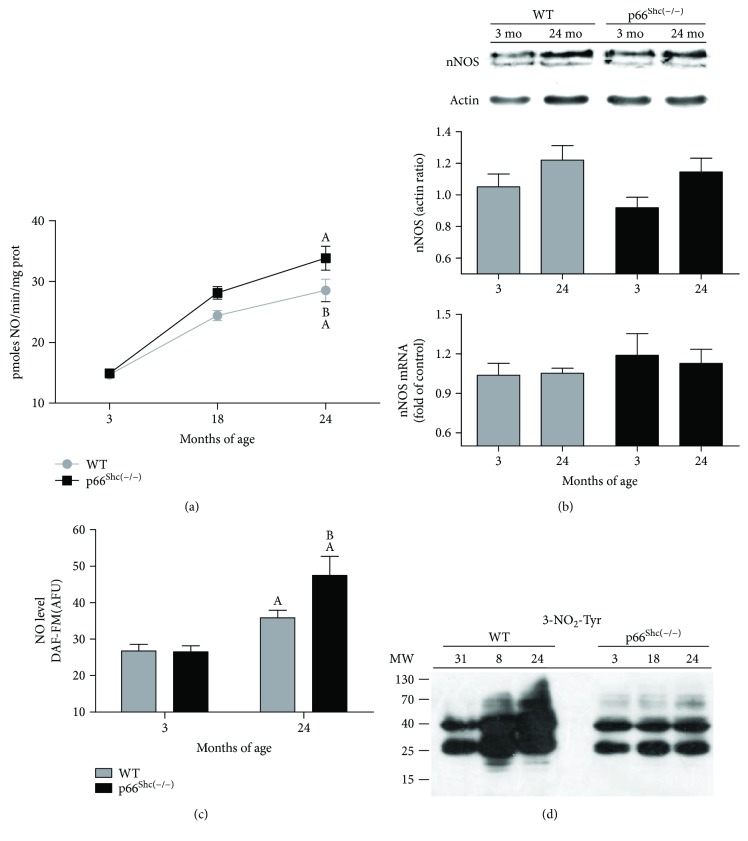
nNOS expression and RNS production in p66Shc(−/−) brain mice during aging. Mice were sacrificed at 3, 18, and 24 months of age. (a) Time course of nNOS activity in mitochondria brain mice measured by 3H-L-citrulline formation (n = 6). (b) RT-qPCR and immunoblot of proteins separated using SDS-PAGE from whole brain lysate reveals nNOS mRNA levels and protein expression of mouse brain in WT (grey) and p66Shc(−/−) (black) groups at 3 and 24 months of age. GADPH mRNA levels and actin protein expression were used as housekeeping control and loading control, respectively (n > 5, for each experimental group). (c) NO levels were obtained from 50 μg/mL of isolated mitochondria incubated with 0.3 mM L-arginine, 10 μM DAF-FM, and 0.5 μM MitoTracker (per duplicate) at 495 nm (excitation) and 515 nm (emission) in the presence or absence of the NOS inhibitor (3 mM L-NAME) from (n ≥ 6). (d) Western blot of nitrated proteins from the different groups; membranes were revealed with anti-3-nitrotyrosine antibodies for each group (n ≥ 3). Values represent means ± standard error of the mean (SEM); A represents p < 0.05 compared to the 3-month-old group, and B represents p < 0.05 between 24-month-old WT and p66Shc(−/−) groups, one-way analysis of variance (ANOVA) and Bonferroni post hoc test.